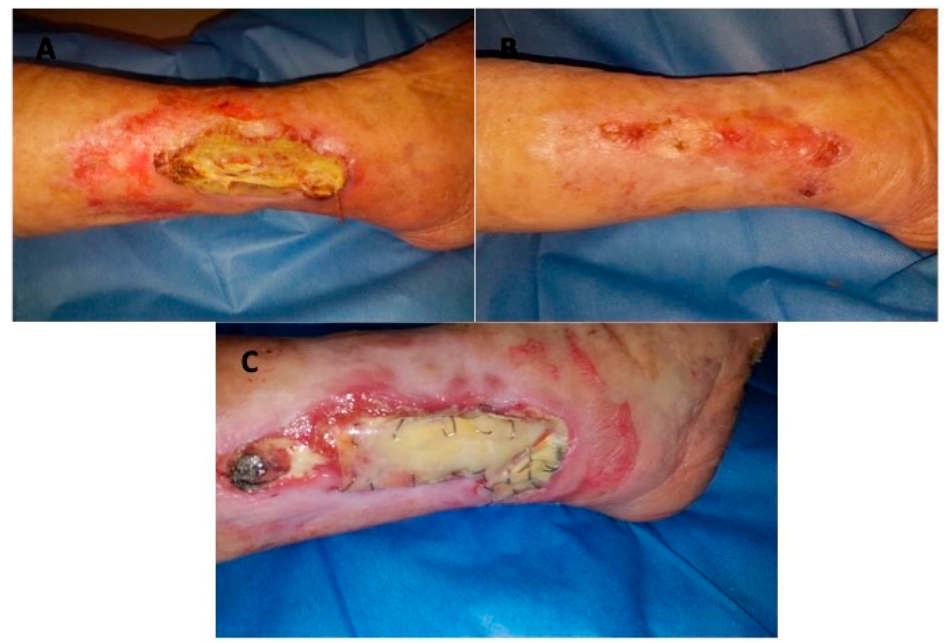
Figure 2. Clinical case. ( A ) Preoperative situation of patient affected by vascular ulcer of left lower limb; ( B ) Postoperative situation showing healing 28 days after DEG; ( C ) Follow-up period during DS application.